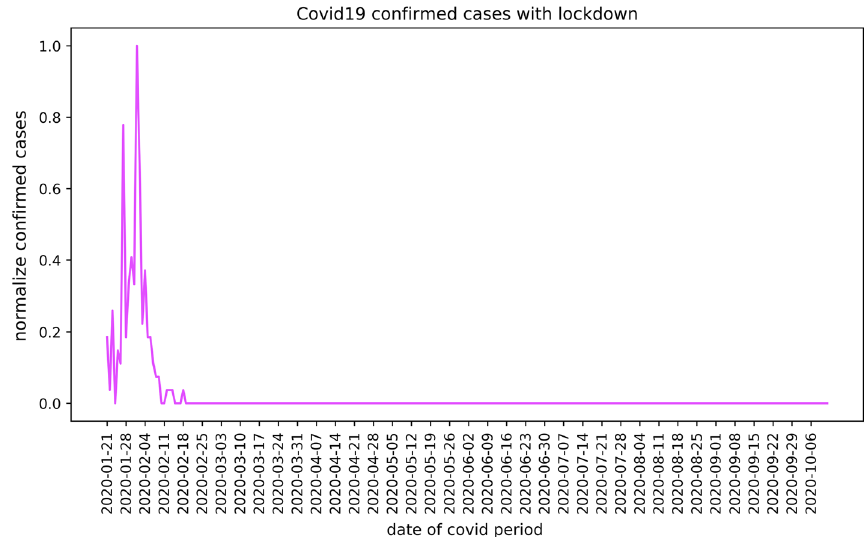
Fig. 5 The number of COVID-19 confirmed cases in